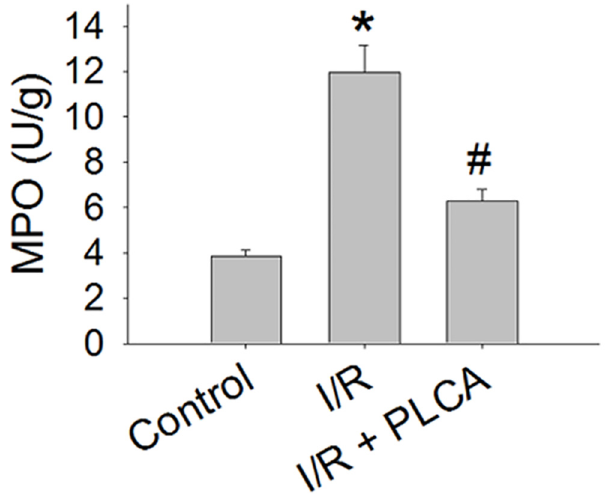
Fig 7. Effect of PLCA on myocardial I/R-induced neutrophil infiltration. Myeloperoxidase (MPO) activity was detected in I/R-injured cardiac tissue. (n = 6) * P < 0.05 vs. control, # < 0.05 vs.